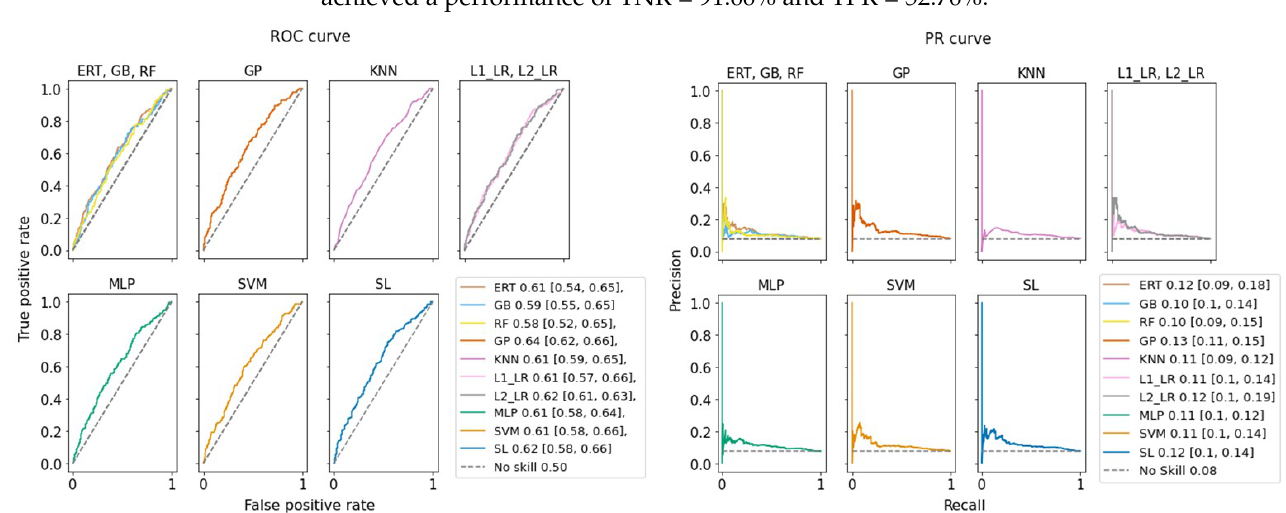
Figure 4. Prediction performance of our ML models. Values shown in legends are areas under the curve and their 95% confidence interval for ( left ) ROC curve and ( right ) precision–recall (PR) curve. F-statistics show no significant difference between predictions.